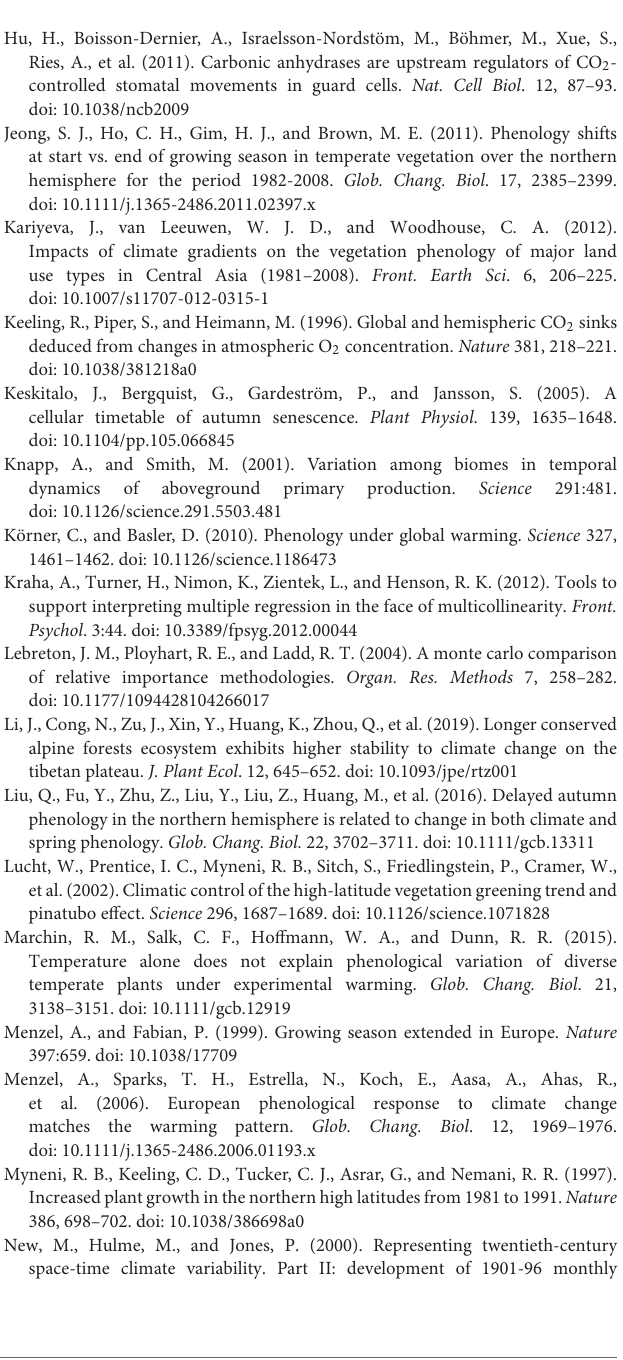
Supplementary Figure 2 | The same climatic factors on SOS and EOS. The area with gray color is the continent, and only a tiny colored pixels indicate the same affecting climatic